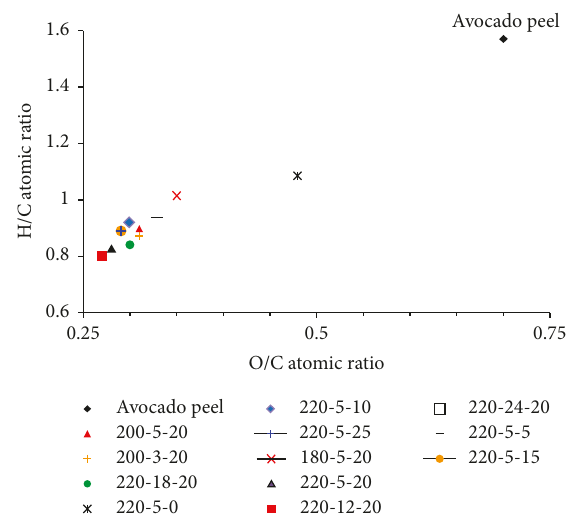
Figure 5: Van Krevelen diagram of feedstock and hydrochar